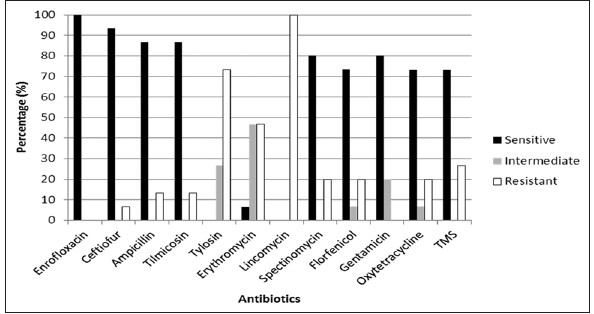
Figure-2: Profiles of antibiotic susceptibility of Pasteurella multocida strains.